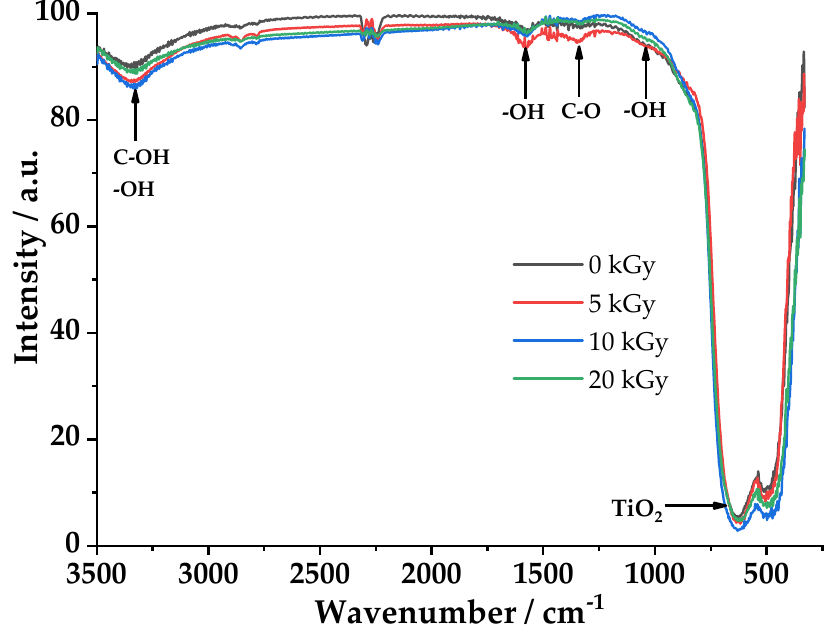
Figure 3. TiO 2 X-ray diffraction with and without irradiation.